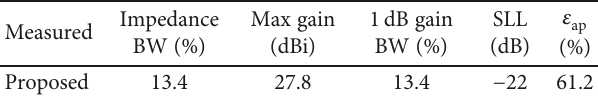
Table 1: The proposed 3D printed re fl ector antenna measured performance at